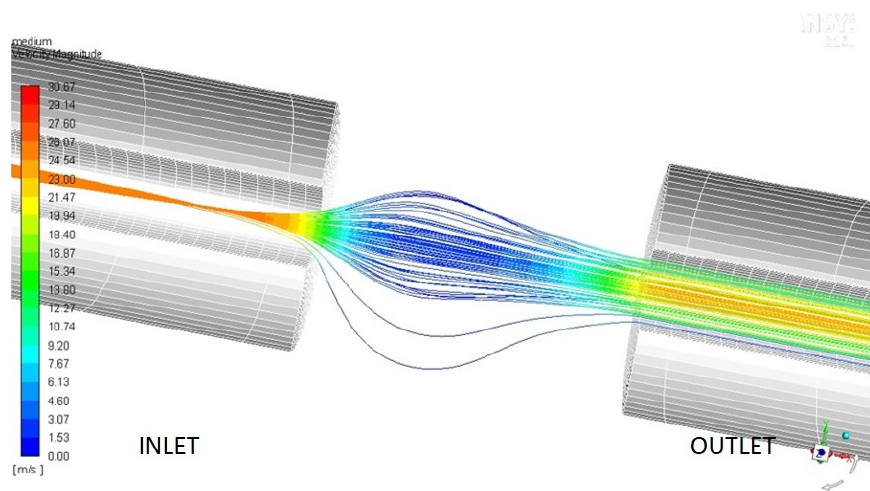
Figure 3. Dust grains behavior inside the sensing section of MicroMED’s Elegant Breadboard .